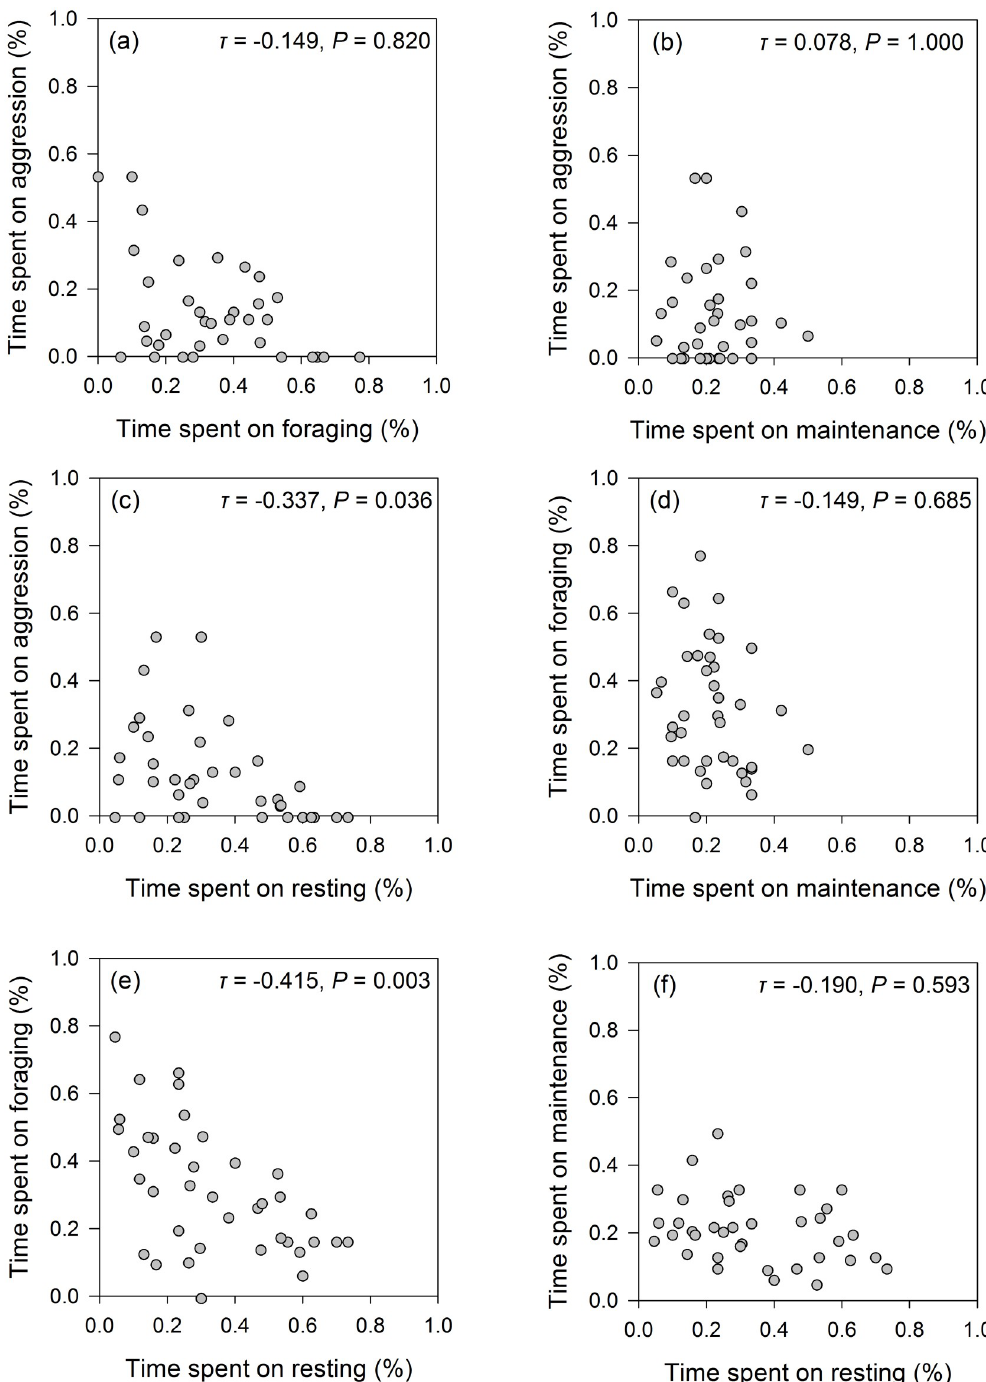
Fig 5. Whooper swan behavioural trade-offs. Kendall’s tau correlations between each of the recorded whooper swan behaviours.